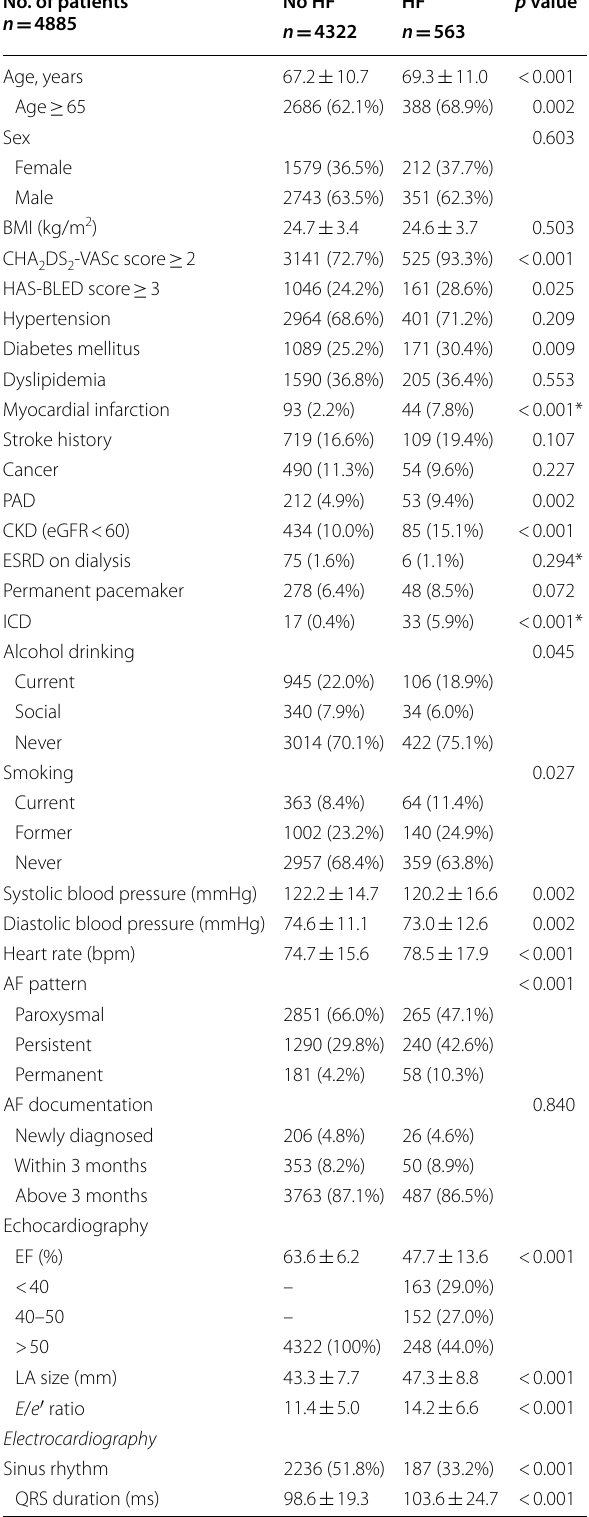
Table 1 General characteristics according to the presence of heart failure in atrial